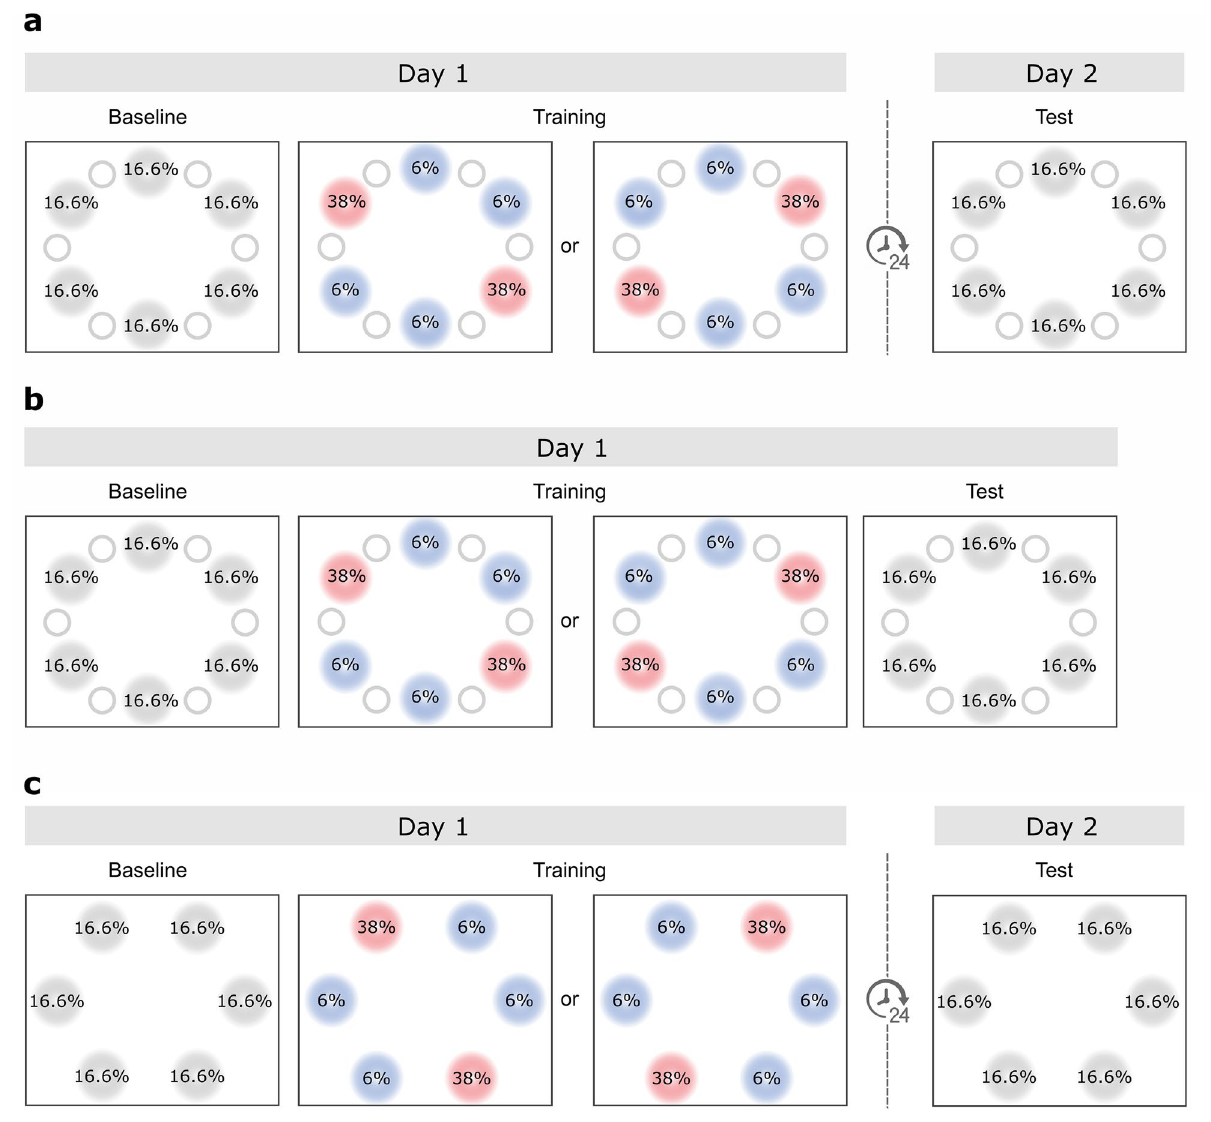
Figure 2. Experimental timeline and stimulus frequency manipulations adopted in the study. Stimulus locations associated with high or low frequency are indicated in red or blue respectively, solely for the purpose of illustration. Locations associated with high stimulus frequency were one on the left and other on the right hemifield, and their specific assignment was counterbalanced across subjects. ( a ) In Experiment 1 Training and Test took place in consecutive days, and the frequency unbalances applied during Training regarded distractor location. ( b ) In Experiment 2 Training and Test took place on the same day within an uninterrupted session, and the frequency unbalances applied during Training regarded distractor location. ( c ) In Experiment 3 Training and Test took place in consecutive days, and the frequency unbalances applied during Training regarded target